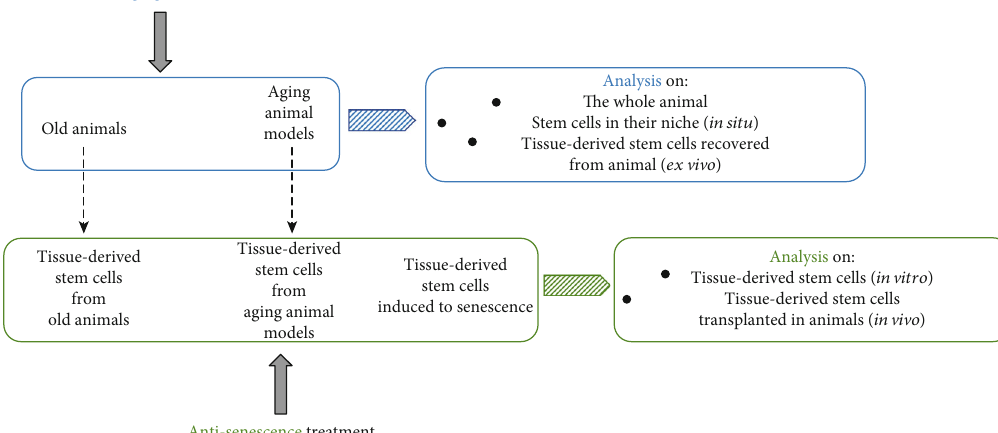
Figure 3: Antiaging and antisenescence research protocols. In antiaging protocols, the animals receive the treatment and then the e ff ects on the whole organism or on its cells are analyzed. In antisenescence protocols, senescent cells receive the treatment and the e ff ects are directly analyzed in culture or after cell